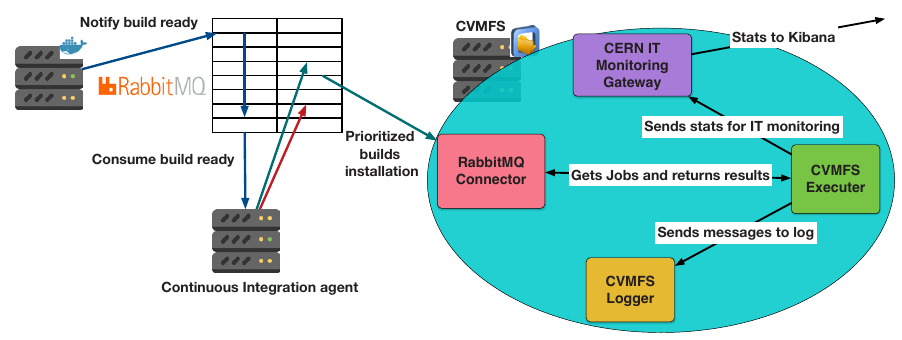
Figure 2. Architecture of LHCb continuous deployment